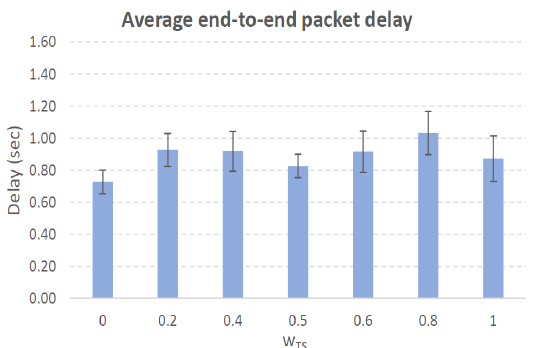
Figure 7. Average end-to-end packet delay. Scenario with very low social media interaction (TS normal distribution with µ = 1 and σ = 1). Nodes’ density = 200 nodes/km 2